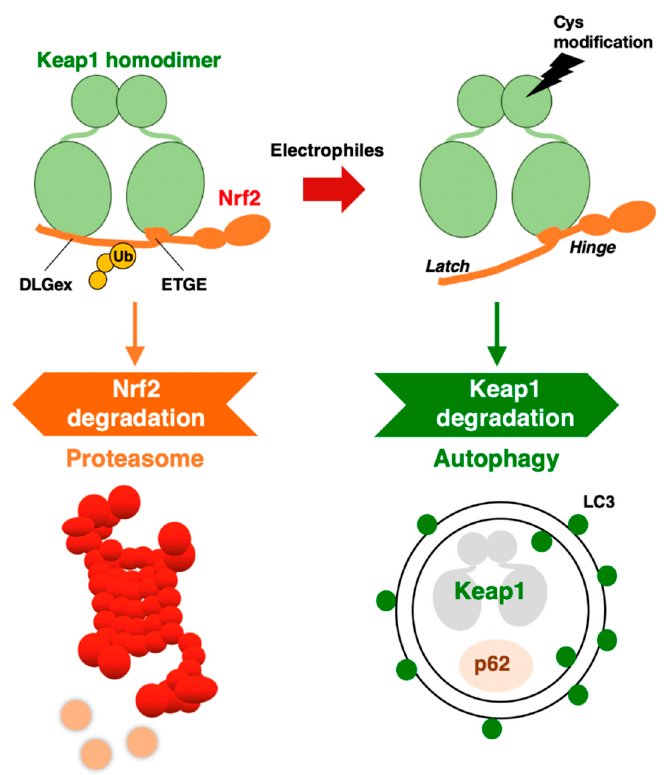
Figure 2. KEAP1–NRF2 system: protein regulation by both proteasome and autophagy.